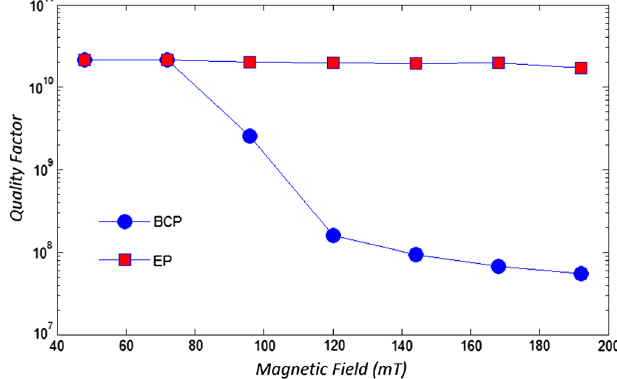
FIG. 18. Comparison of the calculated effective cavity quality factor simulated for representative fine grain Nb BCP ’ d and EP ’ d surfaces at different peak H fields in a C100 geometry cavity. Thermal feedback effects are not included.